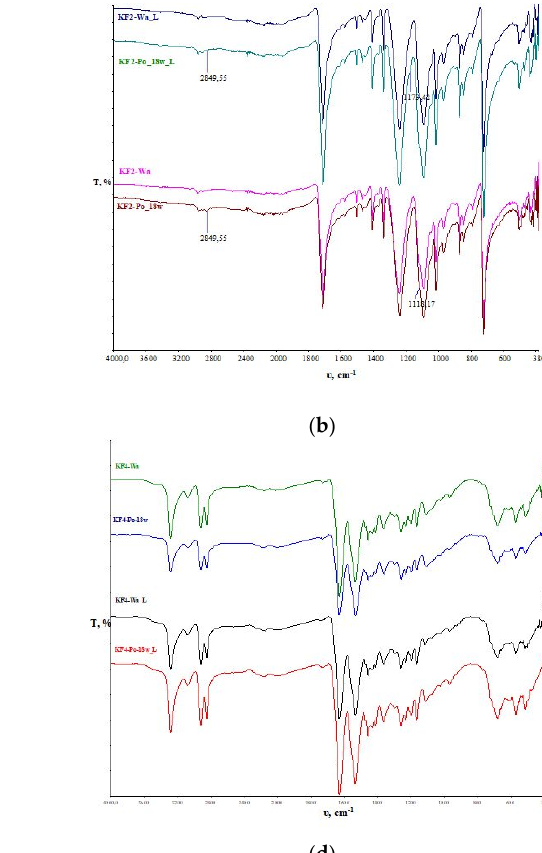
Figure 13. Identification of breakpoints marking the end of the fluid transport phases (WP, SP and ADP): ( a ) outdoor; ( b ) indoor.